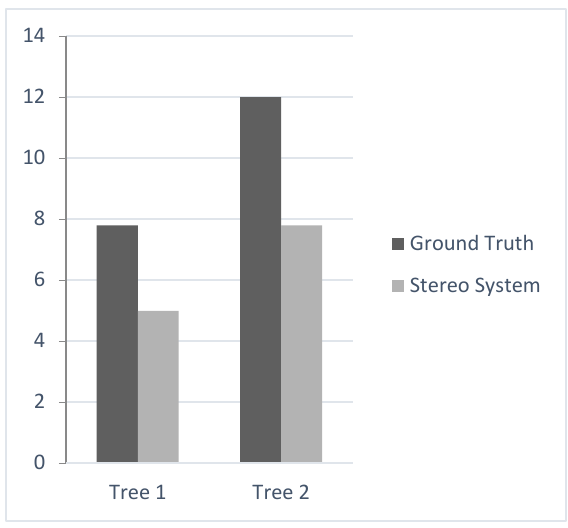
Figure 9. The height comparison